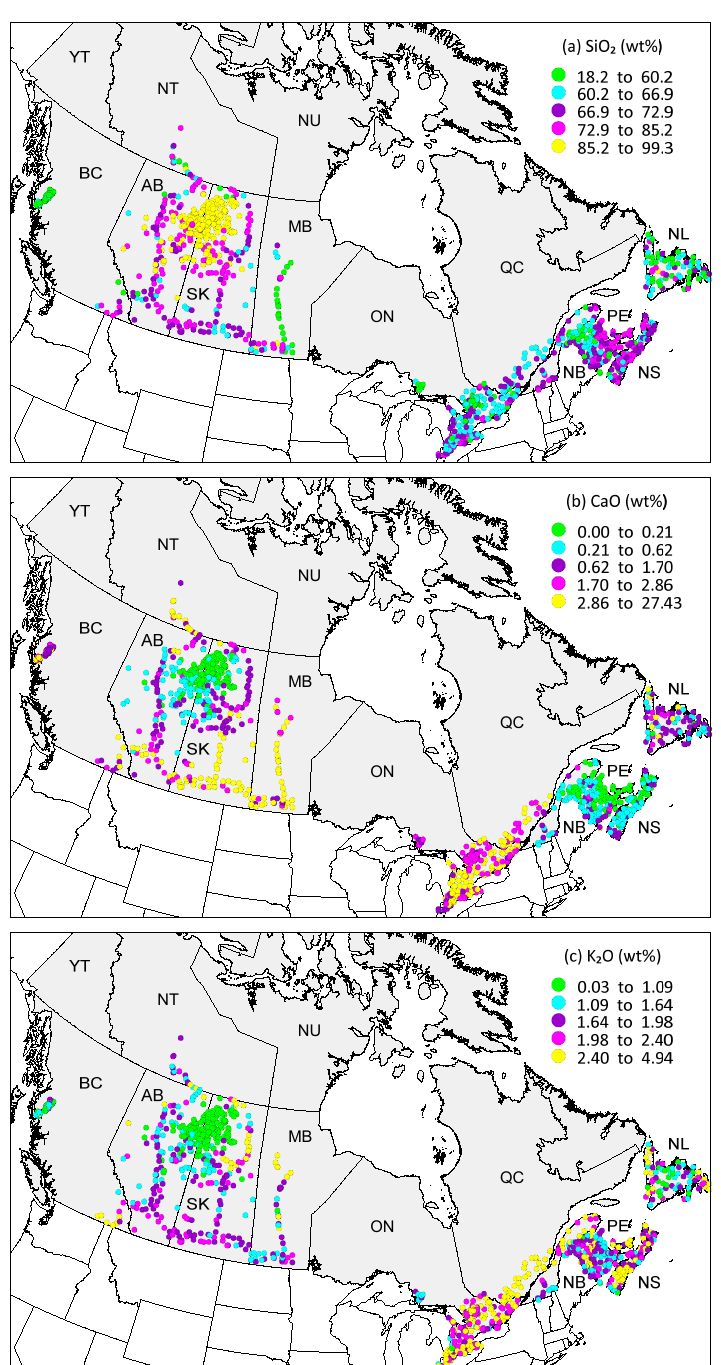
Figure 2. Distribution of ( a ) silicon dioxide [SiO 2 ], ( b ) calcium oxide [CaO], and ( c ) potassium oxide [K 2 O] across Canada ( n = 1170) from the North American Soil Geochemical Landscapes Project and Trent University Soil Archive (see Figure 1). Average oxide content (wt%) for each profile was weighted by horizon depth and bulk density to a maximum soil depth of 50 cm. Legend boundaries were set to obtain an equal distribution of sites among fi ve categories.